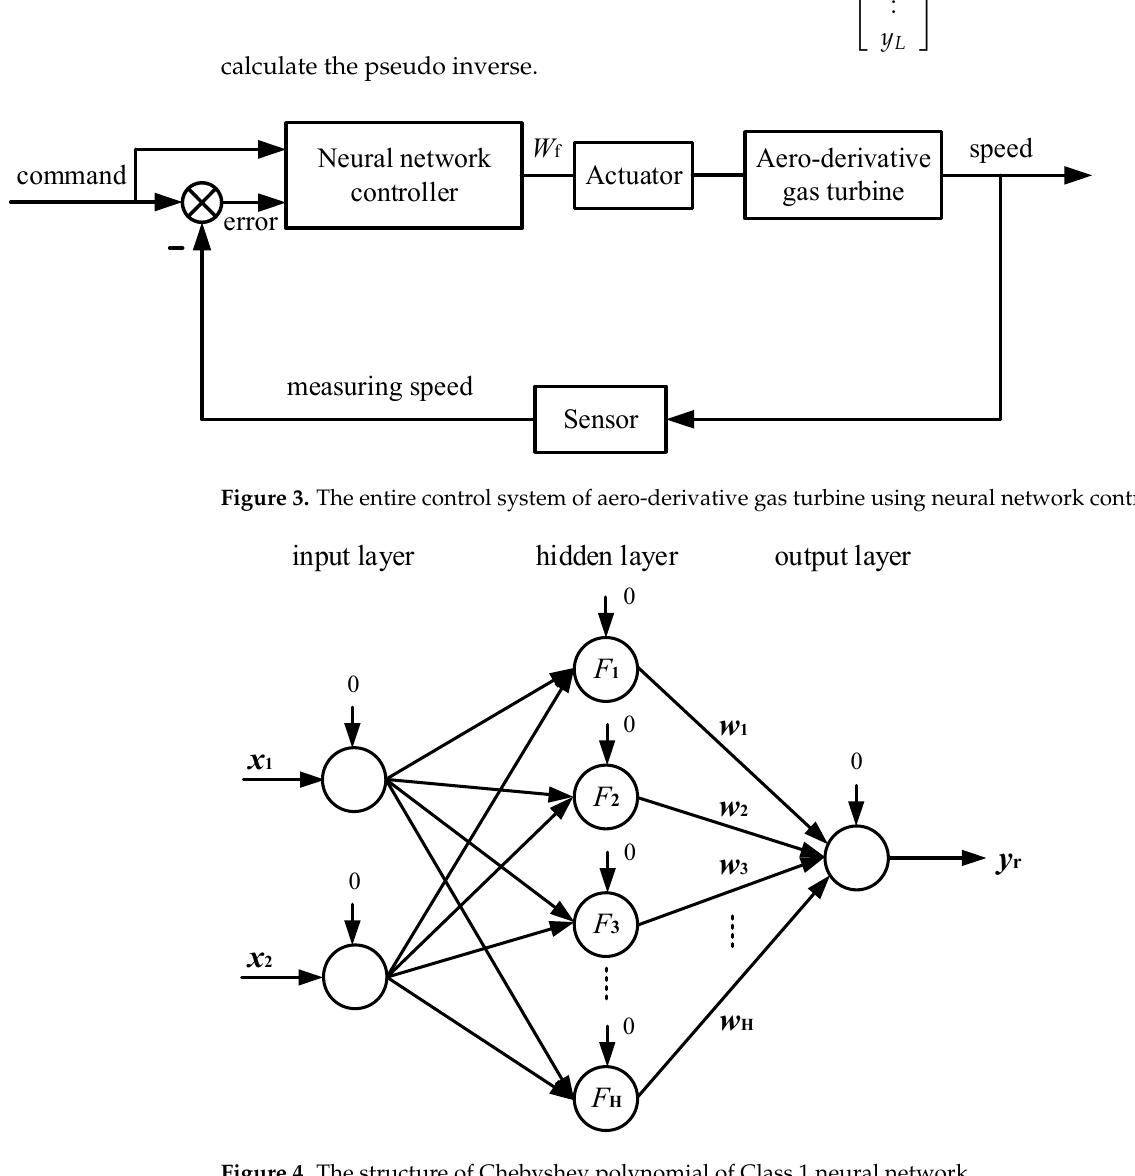
the current number of the Chebyshev polynomial of Class 1 p = 2, and the current minimal number p min = 2. The current minimal half mean square error HE min is set to be 10,